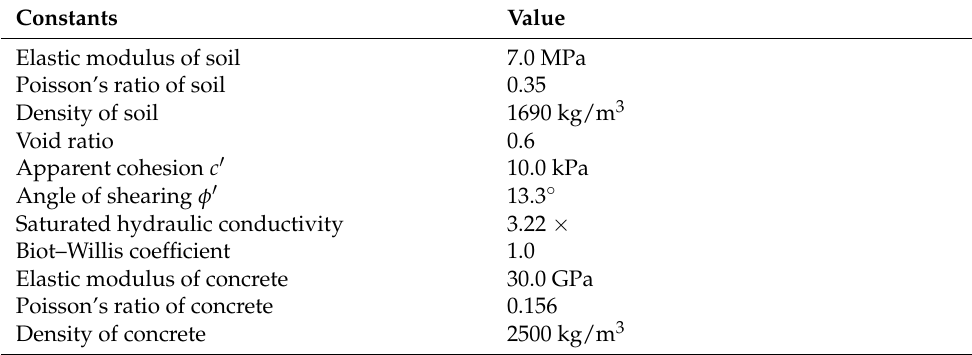
Table 1. Input parameters used in the